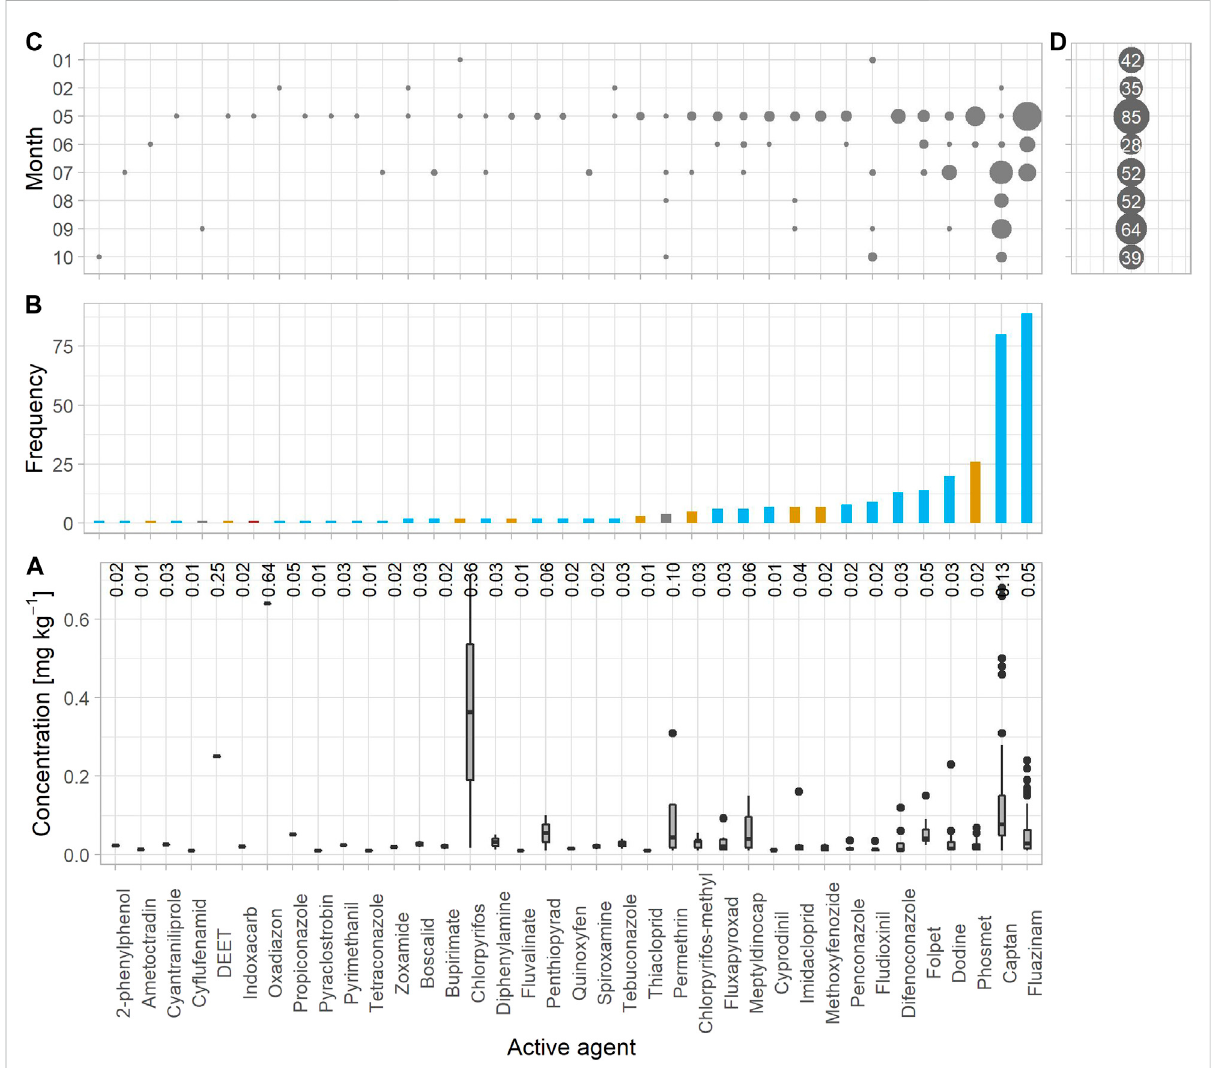
FIGURE 3 (A) Concentrations [mg kg − 1 ] and (B) total frequency of detection ( > 0.01 mg kg − 1 ) of all residues found on the grass samples of 39 different sampling sites.399samples(site xdate)weretakenfrom2018 until2021.Numbers (A) representthemeanconcentrationoverall detections.Color- coded bars represent fungicides (blue), insecticides (orange) and herbicides (green) (C) Months (January – October) in which the residues were detected (sum of 2018 – 2021) and (D) Total number of samples (sum) collected in the corresponding month (sum of 2018 – 2019). The dot size represents the relative frequency of detection per month. The residue concentration refers to the fresh weight of